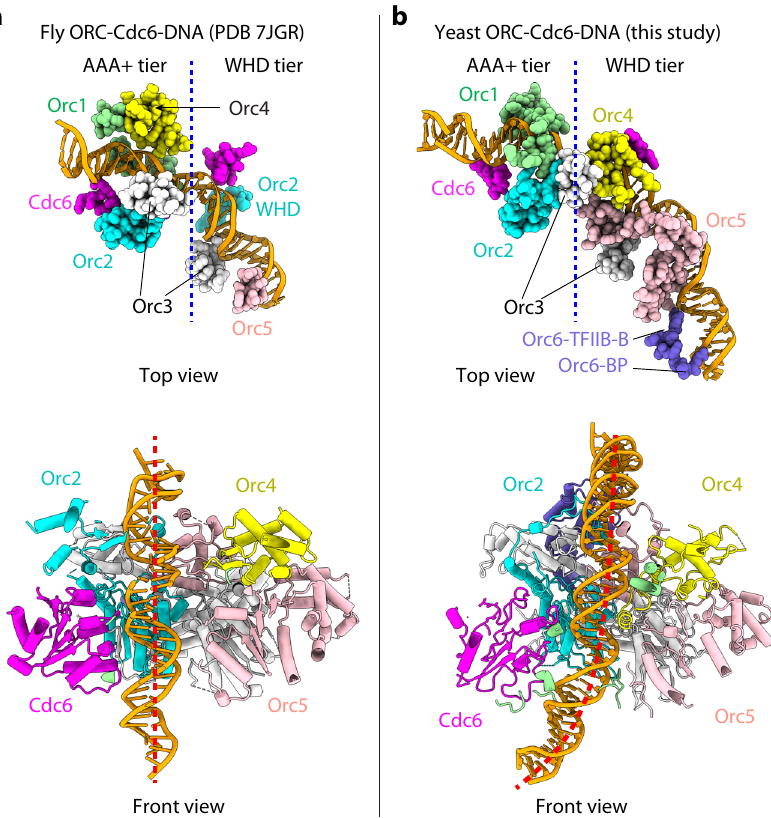
Fig. 4 Comparison of the drosophila and yeast ORC – Cdc6 complexes bound to origin DNA of a similar length. a , b Structure of the fl y ORC – Cdc6 bound to an 82 bp AT-rich dsDNA ( a ) and the yeast ORC – Cdc6 bound to the 85 bp ARS1 origin dsDNA ( b ). The upper panels show top view of protein residues (spheres) that are within 4 Å of DNA. The yeast ORC – Cdc6 complex contains extra contacts with DNA by the Orc4 AAA + domain and the Orc2 WHD domain (unresolved). The lower panels show the DNA binding domains (cartoons) in the complexes in a front view. The fl y DNA is straight, but the yeast origin DNA is bent due to the extra DNA-binding motifs present in the yeast structure (Orc1-BP, Orc4-WHD, Orc5-BP, Orc6-TFIIB-B, and Orc6-BP) but absent in the fl y